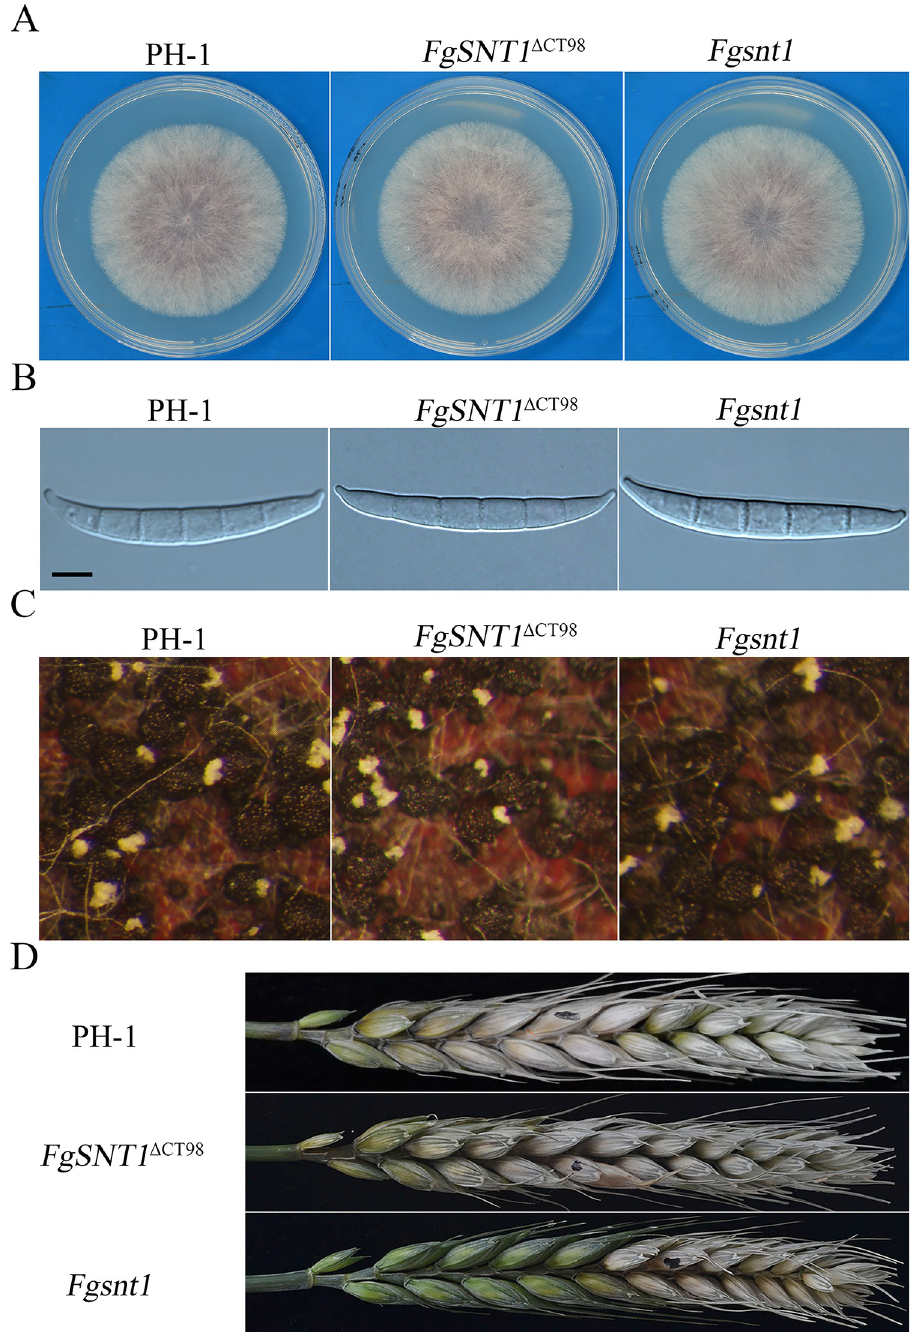
Fig 3. Assays for the phenotypes of the Fgsnt1 and FgSNT1 Δ CT98 mutants. (A). Three-day-old PDA cultures of the wild type (PH-1) and the Fgsnt1 and FgSNT1 Δ CT98 mutants. (B). Conidia from 5-day-old CMC cultures were examined for morphological defects. Bar = 10 μ m. (C). Perithecia from mating cultures of the marked strains were examined at 12 dpf. (D). Wheat heads inoculated with the marked strains were examined for head blight symptoms at 14 dpi. Black dots mark the inoculated